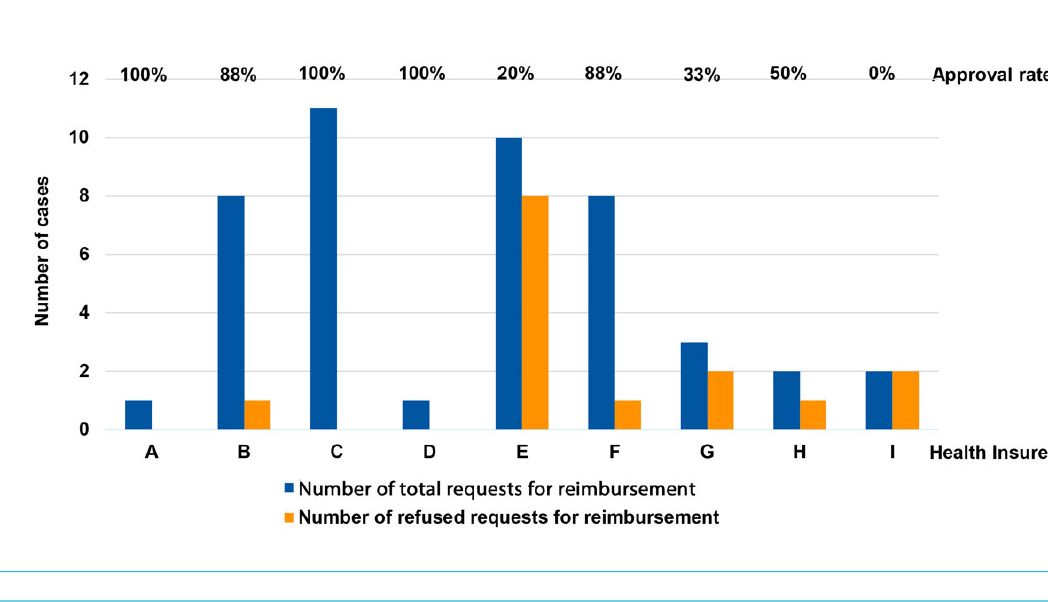
Figure 3: Final decisions per year from 2017–2020. * Includes the first 6 months